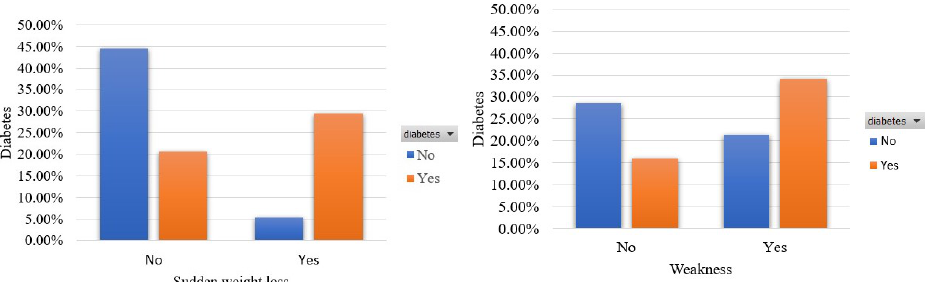
Figure 3. Participants’ distribution in terms of sudden weight loss and weakness in the bal- anced dataset.